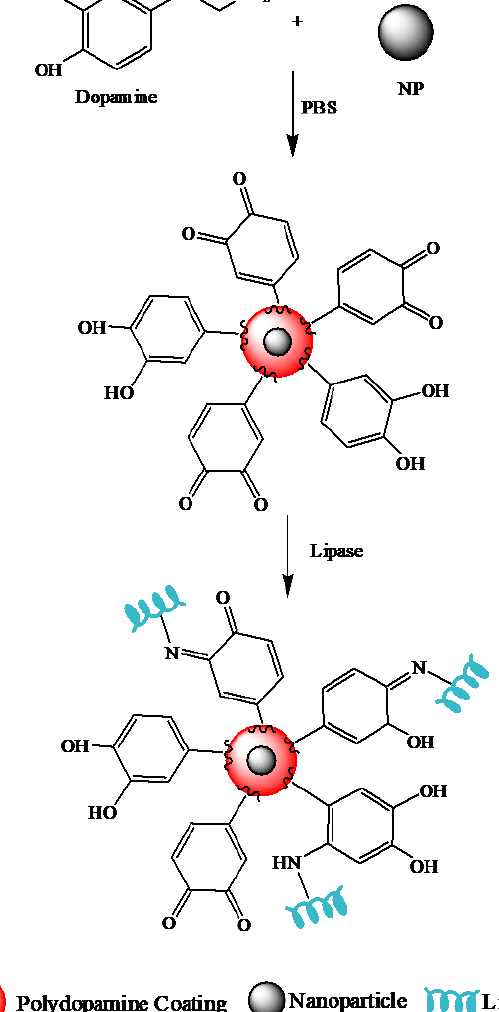
Figure 1. Schematic representation of lipase immobilization on dopamine coated.